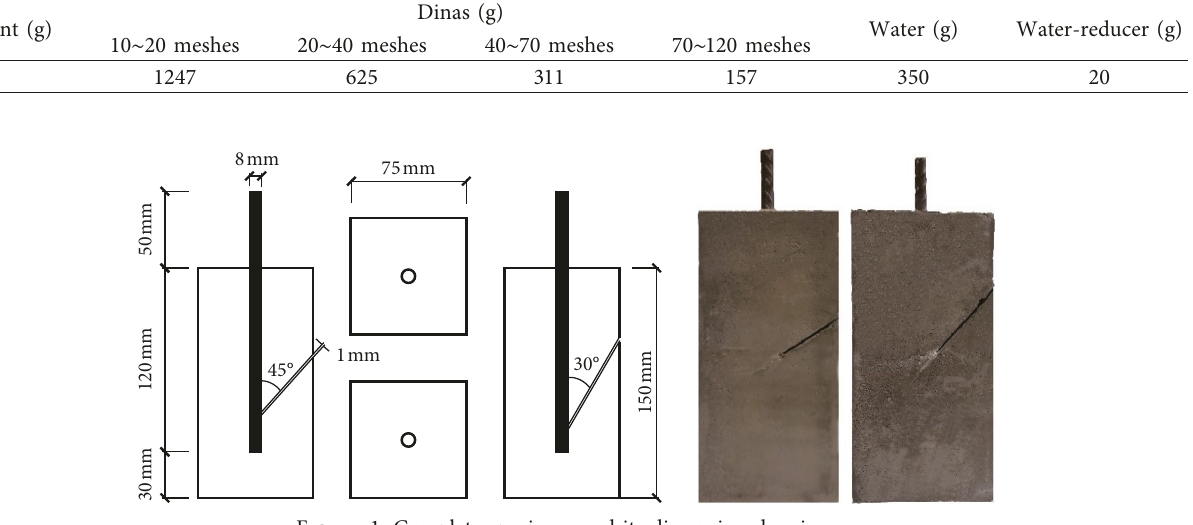
Table 1: Mix proportion of mortar quality.